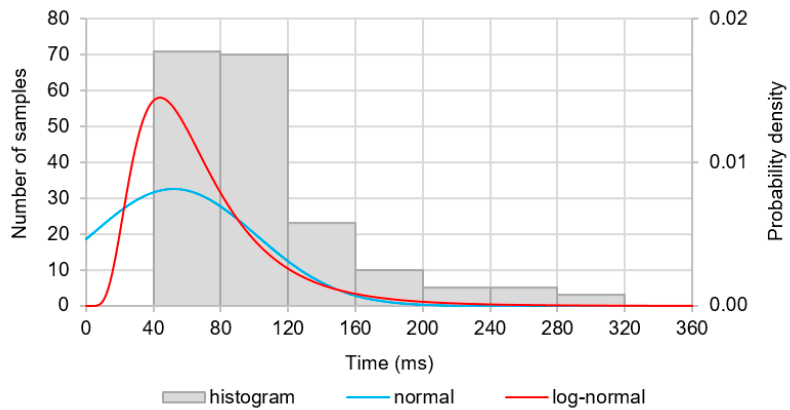
Figure 5. Histogram and the normal and log-normal operating time distributions for LZ-32 protection with instantaneous setting.